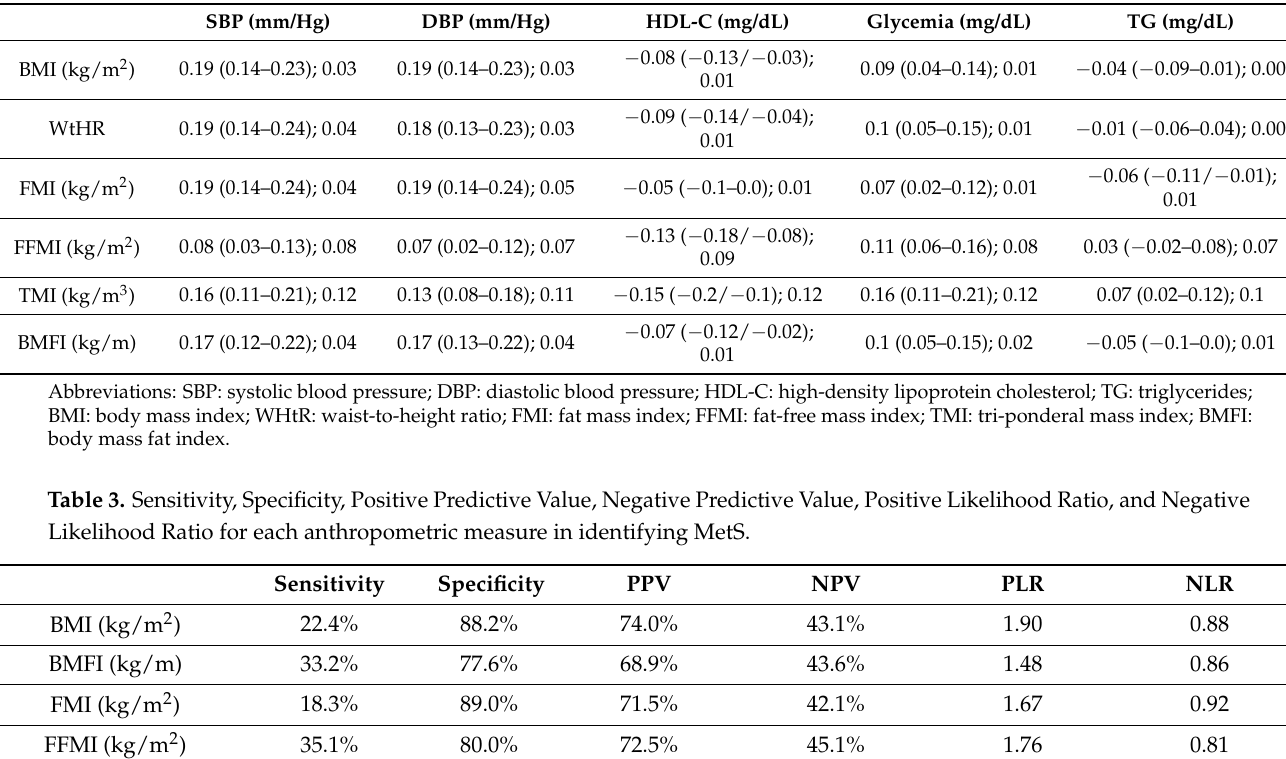
Table 2. Beta estimates and R 2 values relating each anthropometric measure to cardiovascular risk outcome. All models adjust for age. The values reported for each parameter are standardized coefficient of the regression of the cardiovascular risk measures on anthropometric measures, the confidence interval of the coefficient (in brackets), and the correlation coefficient.